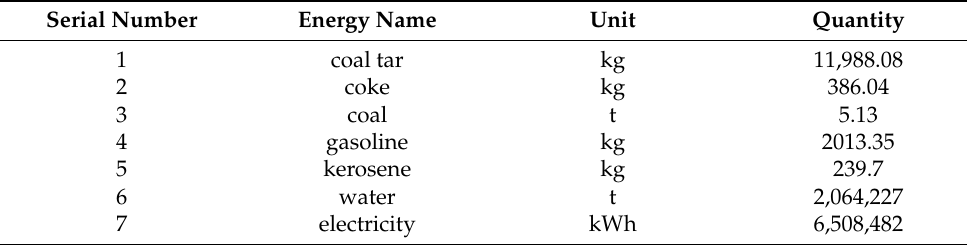
Table 11. Energy